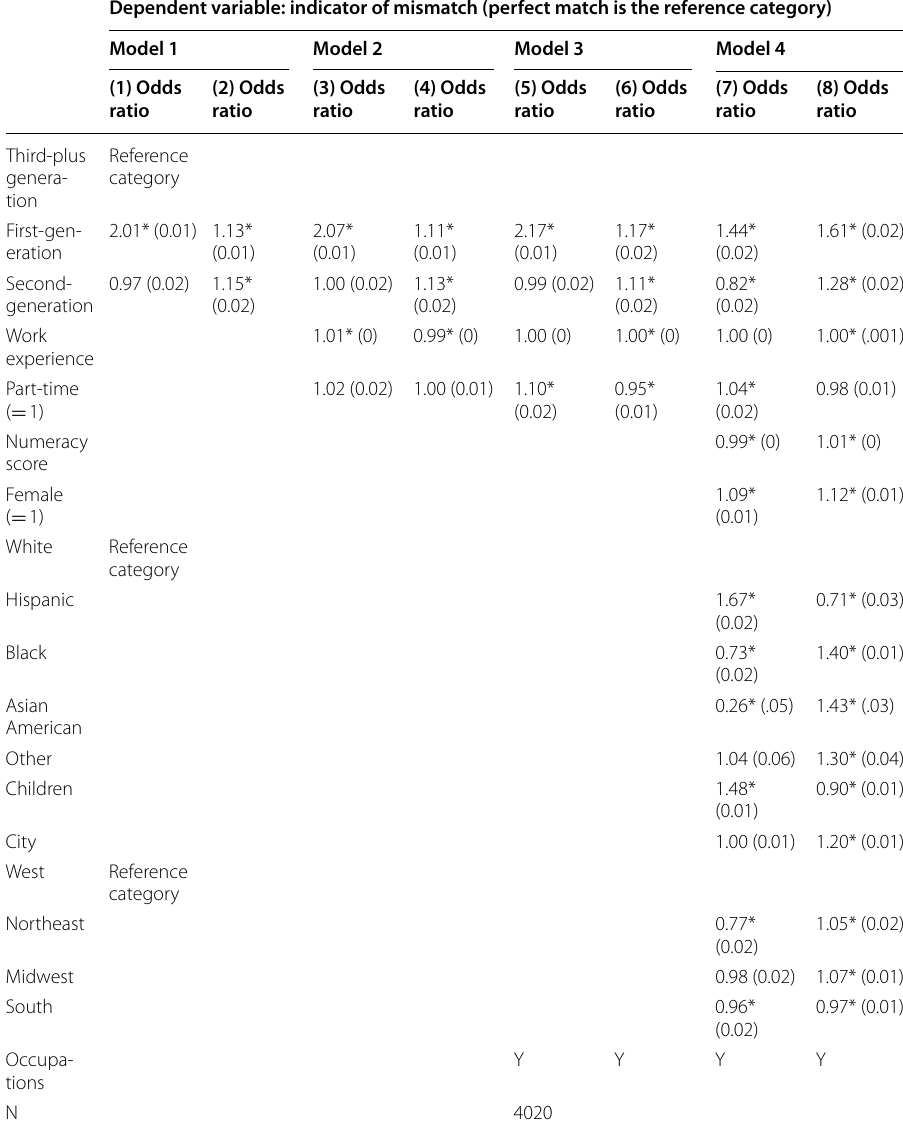
The estimates for the under matched category are reported in the odd-numbered columns, estimates for the overmatched category are reported in the even-numbered columns. All reported estimates represent odds ratios, Standard errors for the coefficient estimates are listed in parentheses below the corresponding odds ratios *p-value <